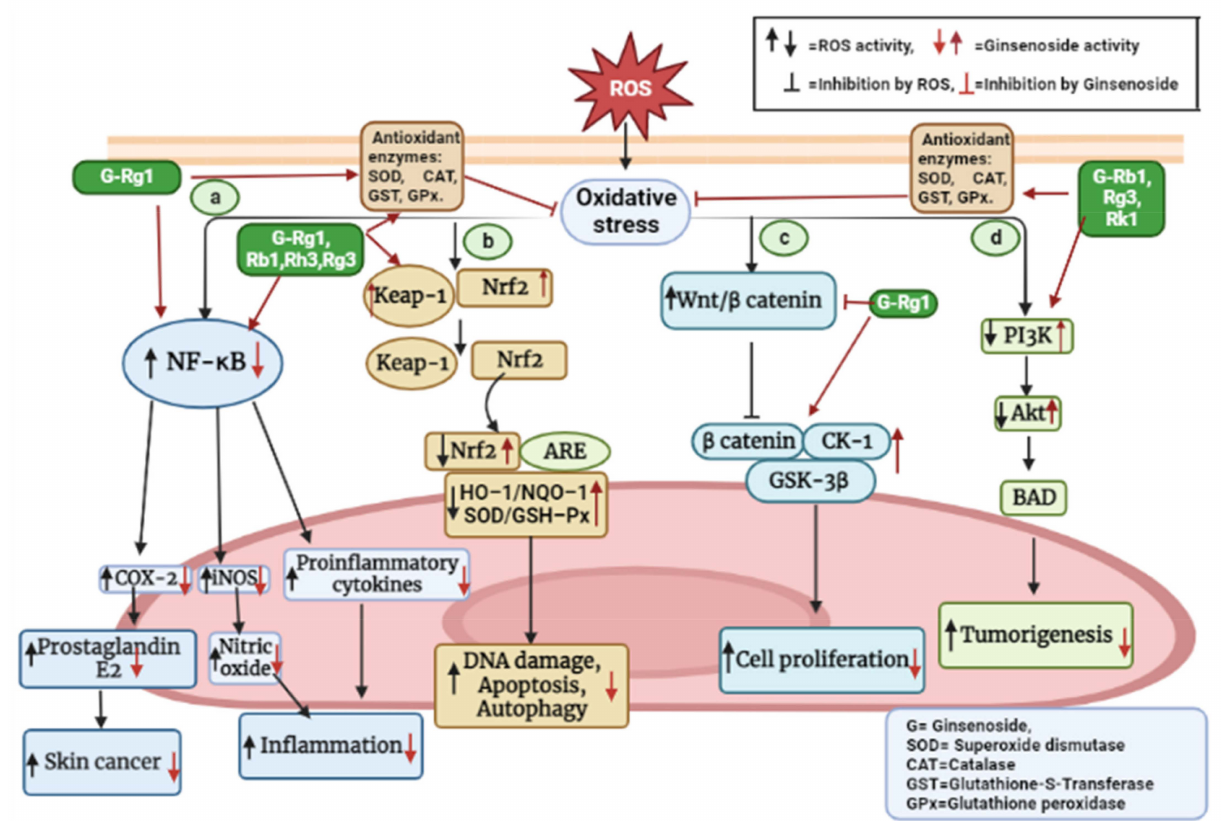
Figure 3. The overproduction of ROS causes oxidative damage which dysregulates several signaling pathways. (a) Oxidative stress increases NF- κ B, thus increasing the expression of COX-2, iNOS, and pro-inflammatory cytokines that may cause skin cancer and inflammation. However, ginsenosides Rg1, Rg3, Rb1, and Rh3 increase the antioxidant enzymes (SOD, CAT, GST, and GPx) activity, which suppresses the activation of NF- κ B and oxidative stress totrigger skin cancer and inflammation. (b) In extreme antioxidant stress conditions, Nrf2 dissociates from keap1 and binds with the ARE which down-regulates the antioxidant enzyme production, resulting in DNA damage, apoptosis, autophagy, etc., whereas, Rg3, Rb1, and Rh3 increase the antioxidant enzymes by activating the Nrf2 that suppresses the disease conditions. (c) During oxidative stress, β -catenin is not decomposed, leading to the activation of the Wnt/ β -catenin pathway. Ginsenoside Rg1 inhibits Wnt activation and increases the activation of β catenin, glycogen synthase kinase-3 (gsk-3), and casein kinase-1 (CK-1) proteins that reduce cell proliferation; (d) similarly, ginsenosides Rg3, Rb1, and Rk1 increase antioxidant enzyme activity and PI3K/Akt to decrease oxidative stress and tumorigenesis. Abbreviations: (ROS- reactive oxygen species, MMP = matrix metalloproteinases, NF- κ B-nuclear factor-kappa B, COX-2- cyclooxygenase-2, iNOS-inducible nitric oxide synthase, Keap-1-Kelch-like epoxy chloropropane- related protein-1, Nrf-2-nuclear factor erythroid 2-related factor 2, ARE-antioxidant response element, HO-1-Heme oxygenase-1, NQO-1-NAD(P)H: quinone oxidoreductase 1, SOD-superoxide dismutase, GSH-Px = GSH and glutathione peroxidase, CK-1-casein kinase-1, gsk-3-glycogen synthase kinase-3, PI3k-Phosphatidylinositol-3-kinase, and Akt-protein kinase